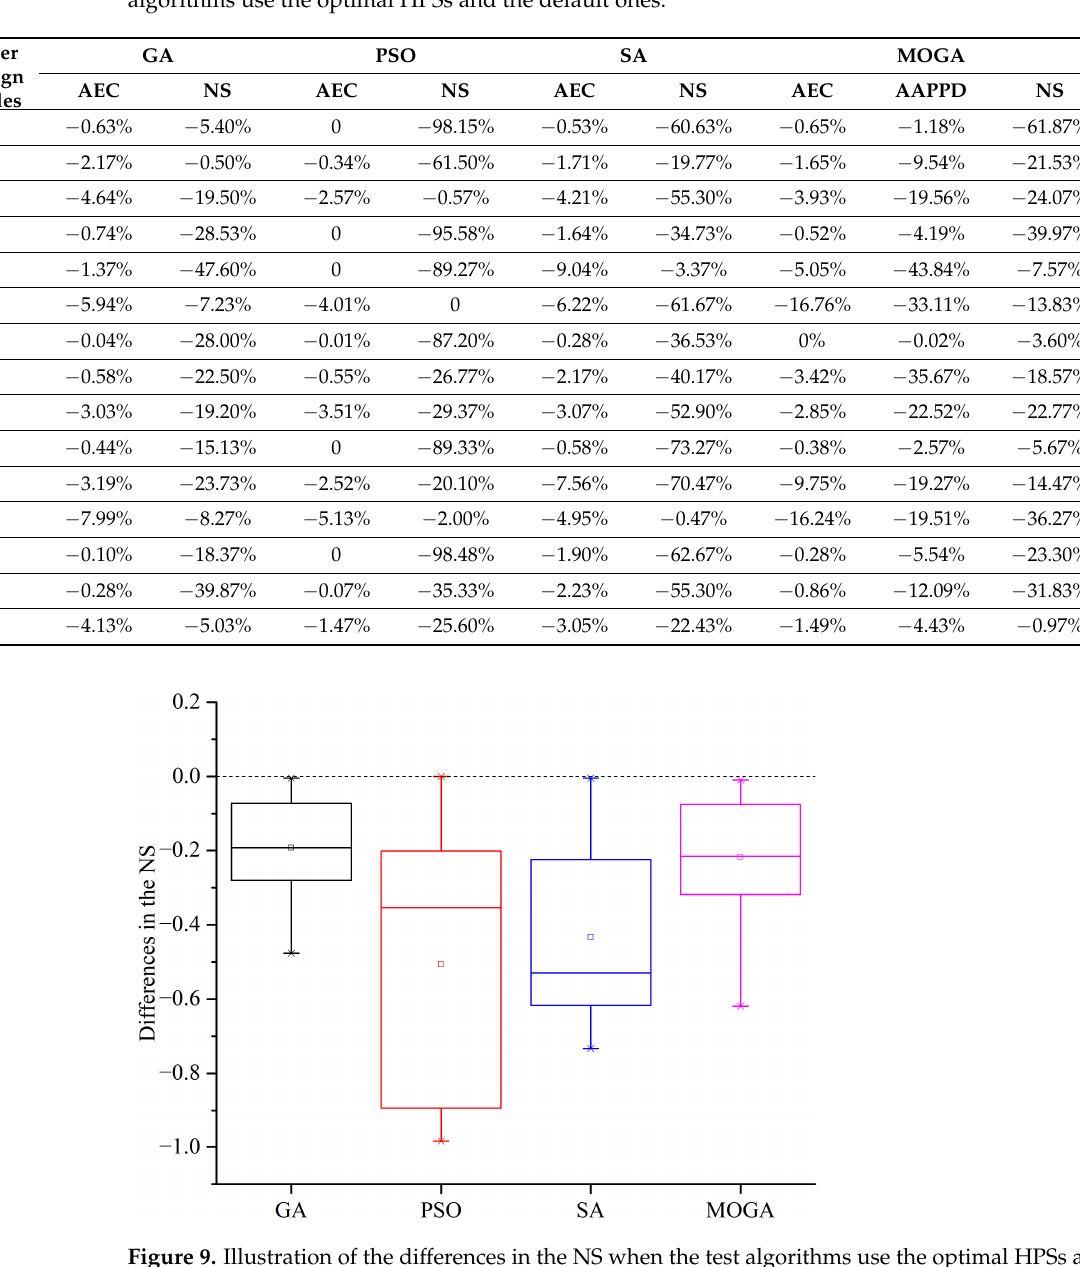
Table 9. Differences in the quality of the optimum and the number of simulations when the test algorithms use the optimal HPSs and the default ones.